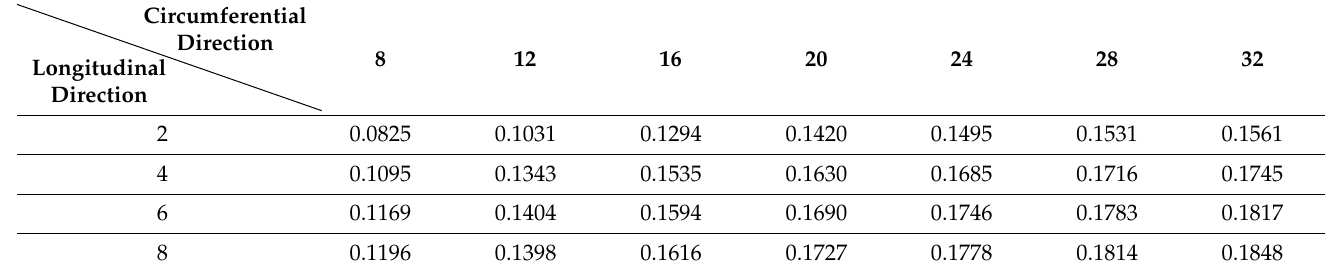
Table 7. Comparison of maximum strain in the piping system.